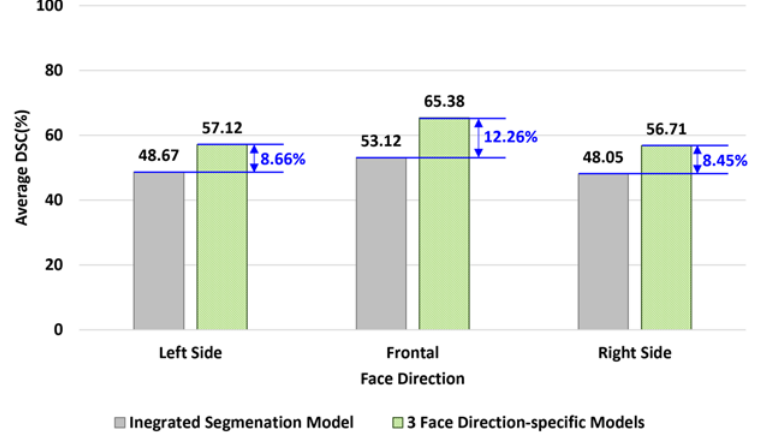
Figure 17. Comparing performances of integrated model and face direction ‐ specific models.